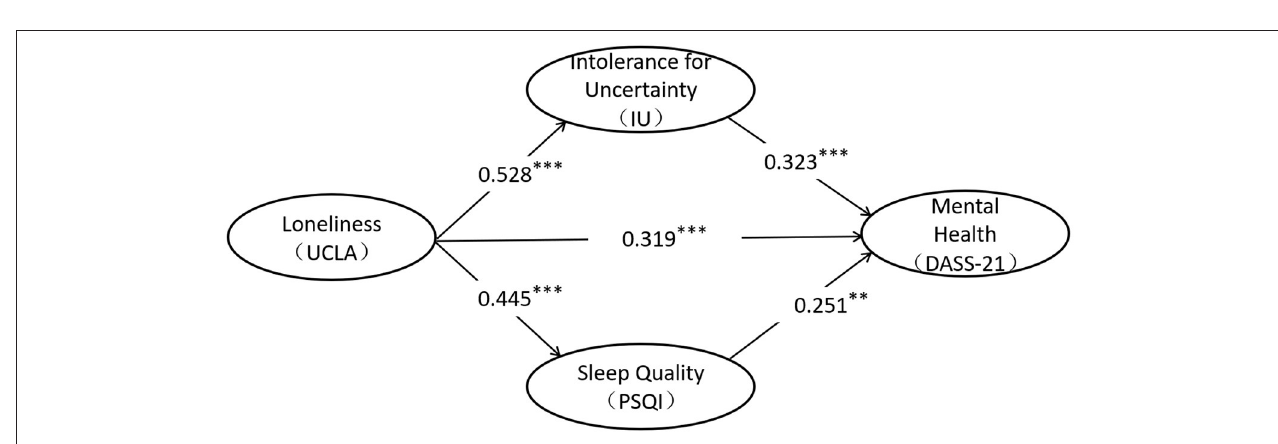
FIGURE 4 | The model of the relationship between loneliness, intolerance for uncertainty, sleep quality, and mental health. ** p < 0.01, ** p < 0.001.